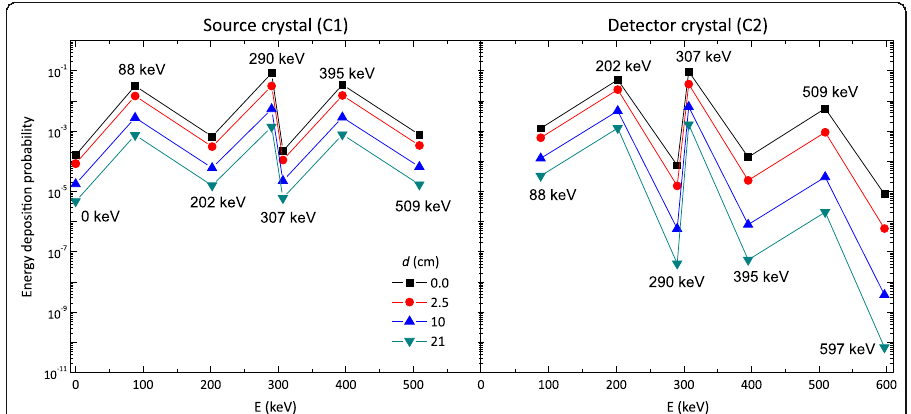
Fig. 4. Energy deposition probability values (from Table 2) for the coincidence detection of a β − particle and gamma rays/IC electrons in the source crystal (C1), and one or more gamma rays with energies of 88, 202 and 307 keV in the detector crystal (C2) for four detector separation distances. Probability values equal to zero are not included in the